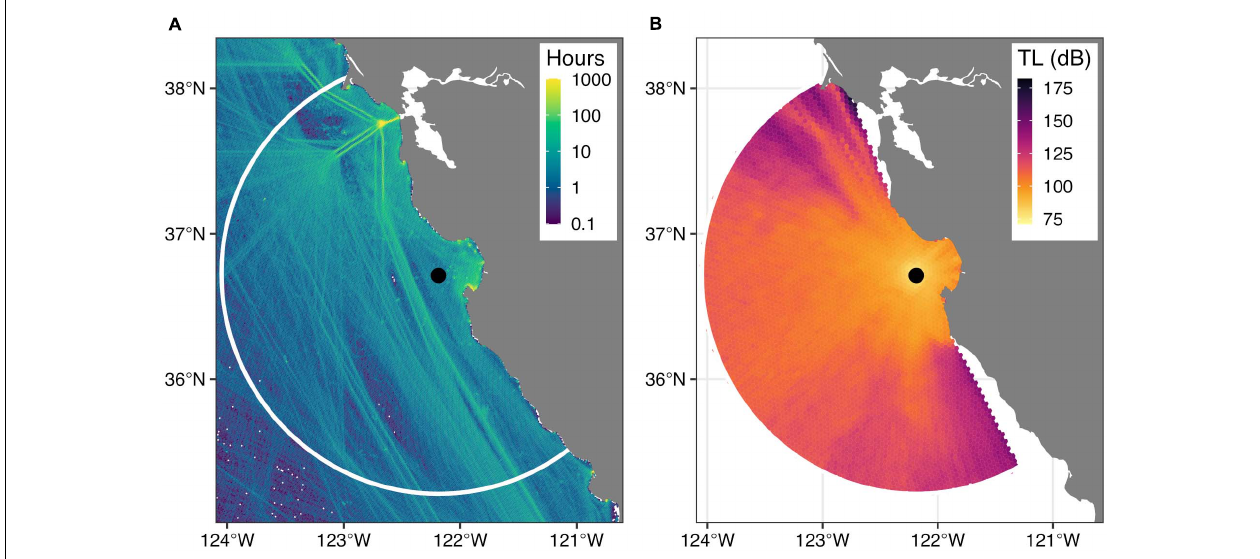
FIGURE 8 | Regional vessel traffic and its weighting. (A) Map of total hours of vessel presence during January through July of 2018–2020, derived from AIS records. Data from within San Francisco Bay were excluded as they would not be relevant to sound recordings at MARS (black circle). (B) Modeled acoustic transmission loss (TL) for a 63 Hz source at 6 m depth (section “Acoustic Modeling”), used as one of two weighting factors for AIS records (section “Automatic Identification System Vessel Tracking Data and Analyses”). The white arc in ( A ) represents a 165-km radius around MARS, corresponding to the domain of TL modeling in ( B ).